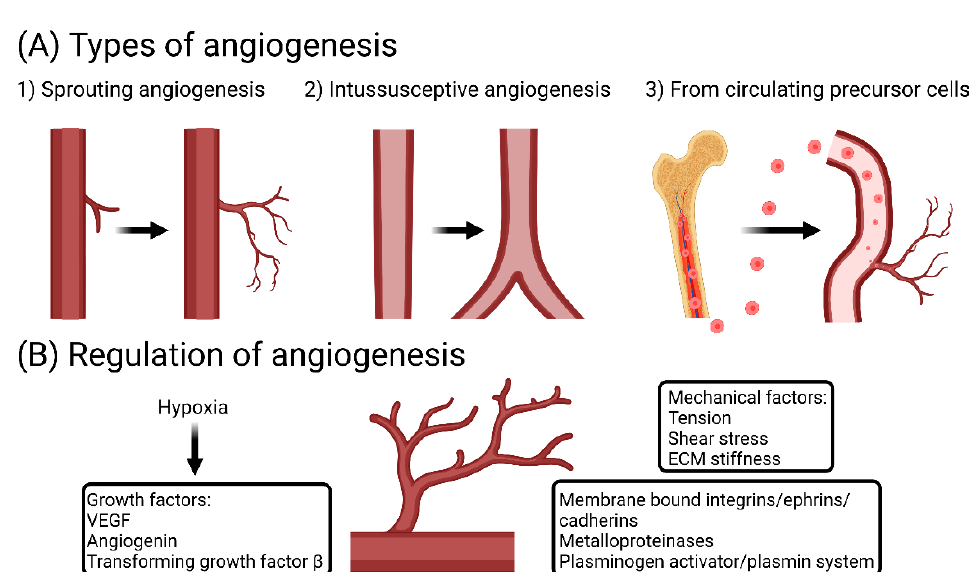
Figure 1. Types of angiogenesis and key regulatory mechanisms. ( A ) Types of angiogenesis. ( B ) Key factors regulating angiogenesis. VEGF: vascular endothelial growth factor, ECM: extracellular matrix.